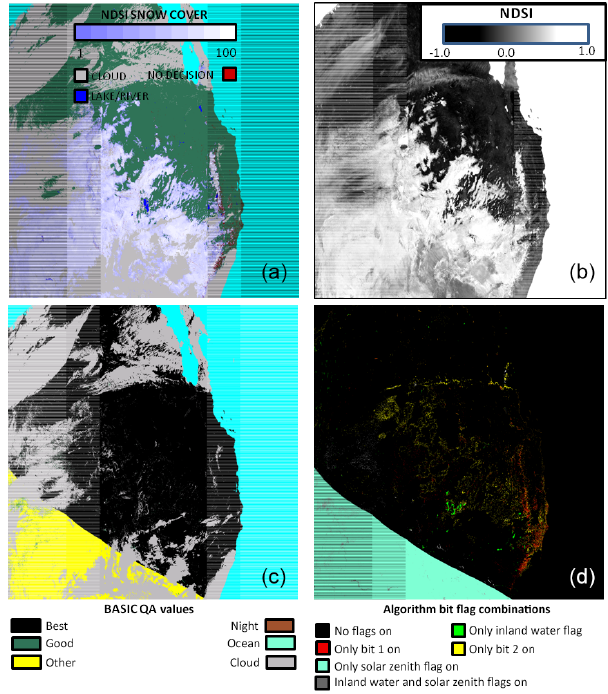
Figure 10. VIIRS C1 VNP10 acquired 18 December 2016 at 20:24UTC, imaging the western CONUS. Datasets: NDSI_Snow_Cover (a) , NDSI (b) , basic QA (c) and a se- lected combination of the Algorithm_bit_flag QA (d) .